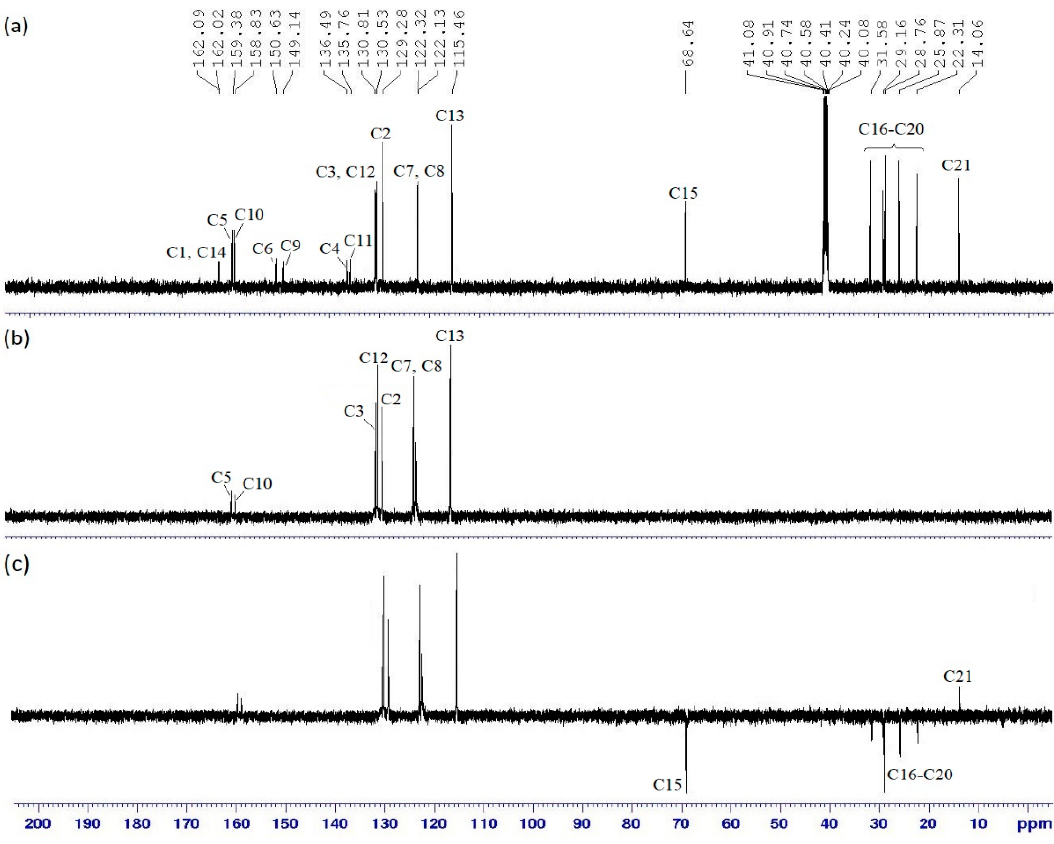
Figure 4. ( a ) 13 C NMR, ( b ) DEPT 90 and ( c ) DEPT 135 spectra of compound 4a .